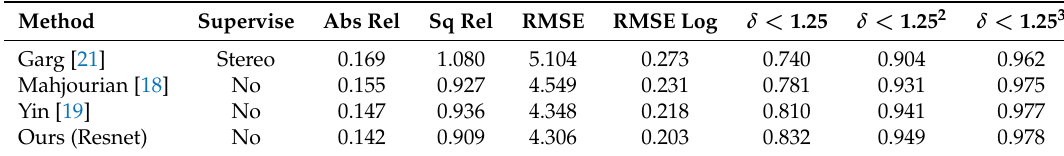
Table 2. Monocular depth results on KITTI by the split of Eigen et al. [10] capped 50 m. Method